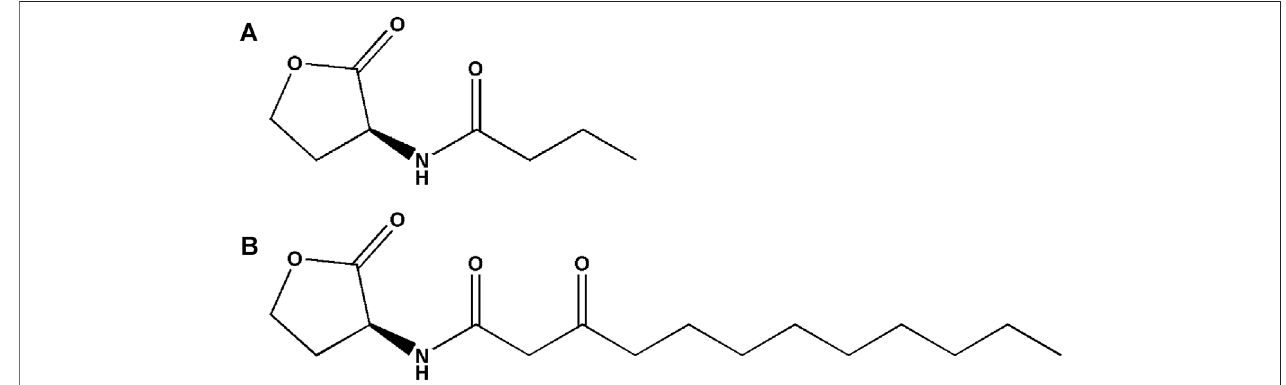
FIGURE 1 | Chemical structure of P. aeruginosa PAO1 natural signal molecule. (A) Structure of BHL and (B) structure of